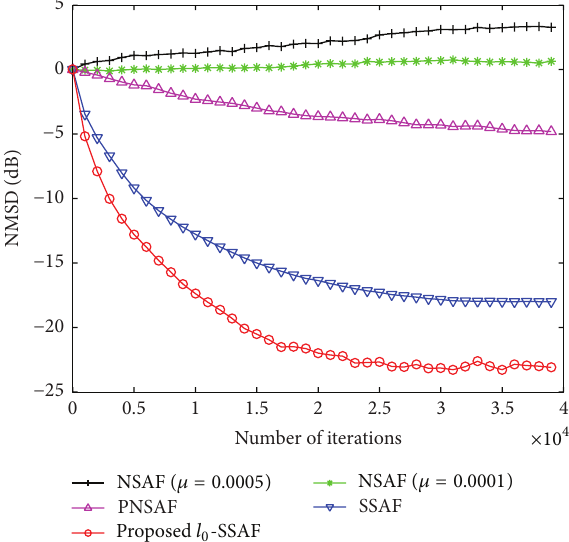
Figure 5: NMSD learning curves of the NSAF, PNSAF, SSAF, and 𝑙 0 - SSAF algorithms for different sparsity ( 𝑆 = 8, 16, 32) [ 𝑁 = 4 , SIR = −30 dB, input: Gaussian AR (1) with pole at 0.9].